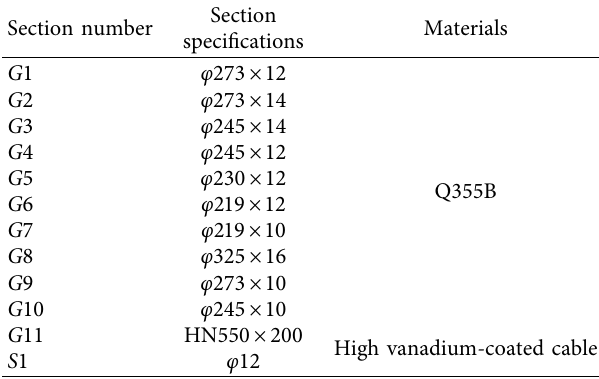
Figure 2: Front view of the integrated model. Table 1: Section specifcations of structural